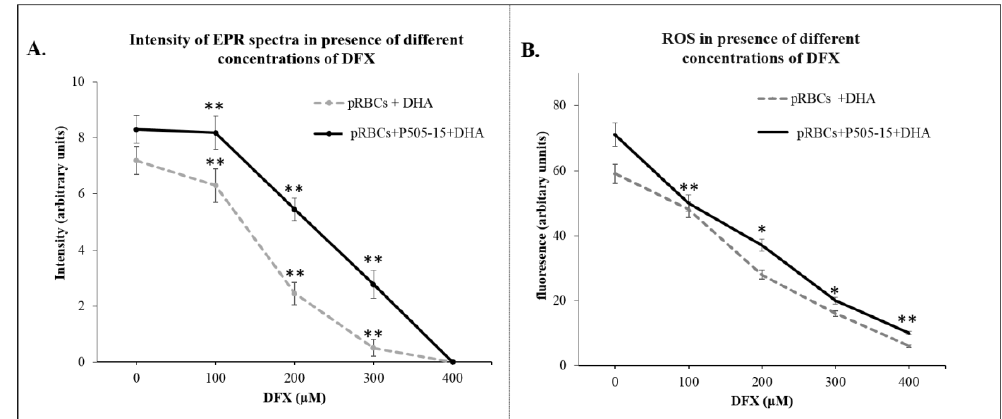
Figure 4. ( A ) Intensity of EPR spectra (arbitrary units) in the presence of PBN spin trapping agent in pRBCs treated with/without P505-15 (0.5 µΜ) for 24 h with/without 10-min incubation with DHA (200 µΜ) and with different concentrations (100–400 µM) of Deferasirox (DFX). ( B ) The same experiments mentioned above ( A ) were performed using the probe CM-H 2 DCFDA. Data are the average ± SD of five independent experiments. Significant differences between untreated DHA-RBCs and pRBCs at * p < 0.05, ** p < 0.001.